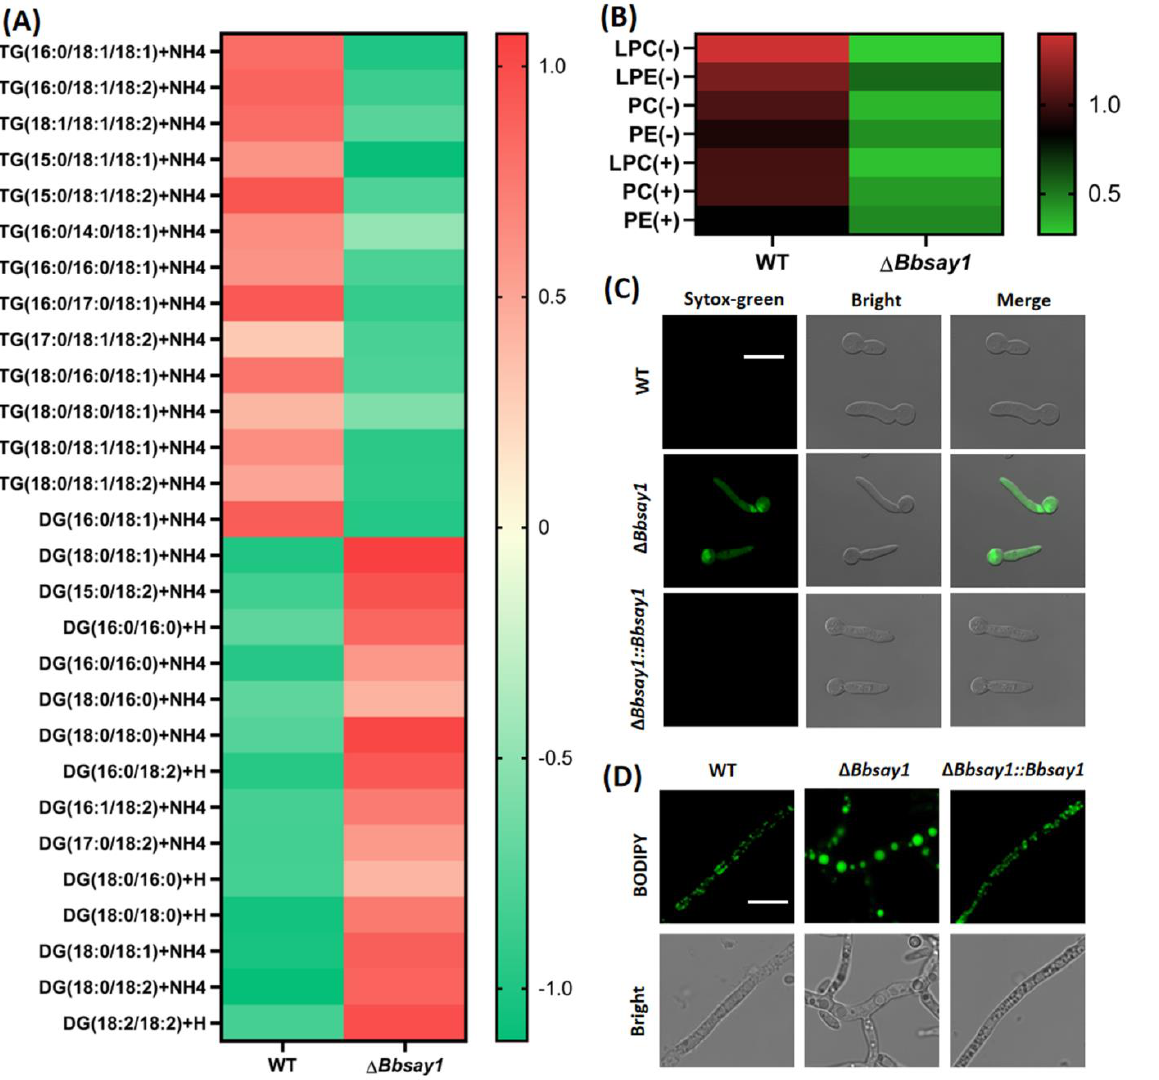
Figure 4. Assay for lipid homeostasis in B. bassiana . The lipidomic assay indicated that the ablation of BbSAY1 resulted in the impaired homeostasis of a neutral lipid ( A ) and phospholipid ( B ). ( C ) Sytox-green nucleus staining. The ∆ Bbsay1 mutant strain displayed anincreased cytomembrane permeability, and its nuclei were easily stained by fluorescent dye. ( D ) Staining lipid bodies. The fluorescent dye BODIPY was used to stain the lipid bodies in fungal cells. The ∆ Bbsay1 mutant strain accumulated the enlarged lipid bodies, which indicatedthe unbalanced lipid metabolism after the ablating of BbSAY1 .